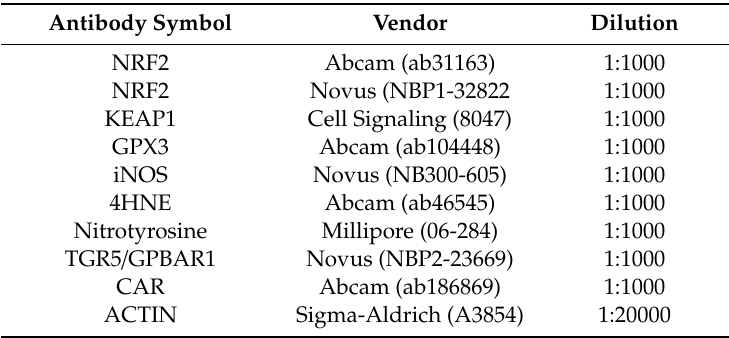
Table 2. Antibodies used in western blot analyses. Antibody